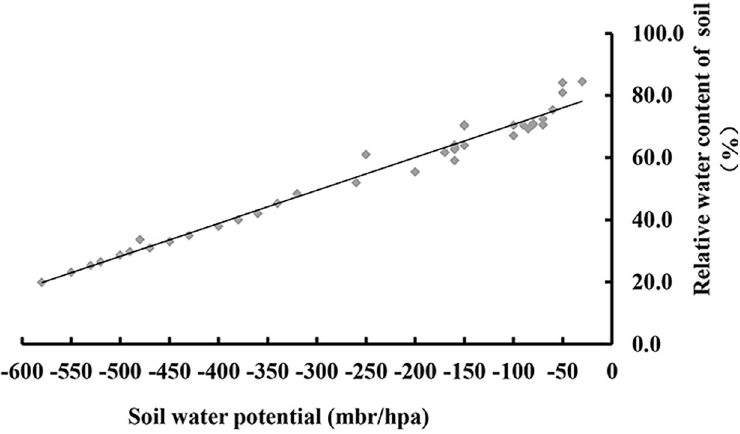
Fig 2. Relationship between soil water potential and soil relative water